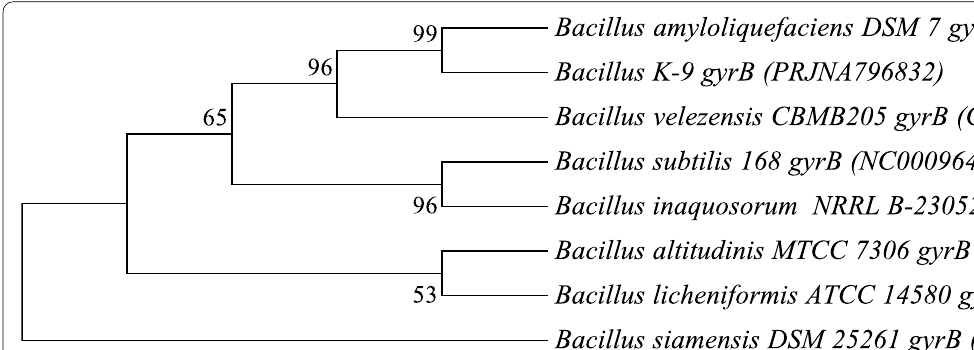
Fig. 3 Phylogenetic tree of strain K-9 constructed based on gyrB gene sequence. Bootstrap values (%) presented at the branches were calculated from 1000 replications. The scale bar means 5% sequence difference